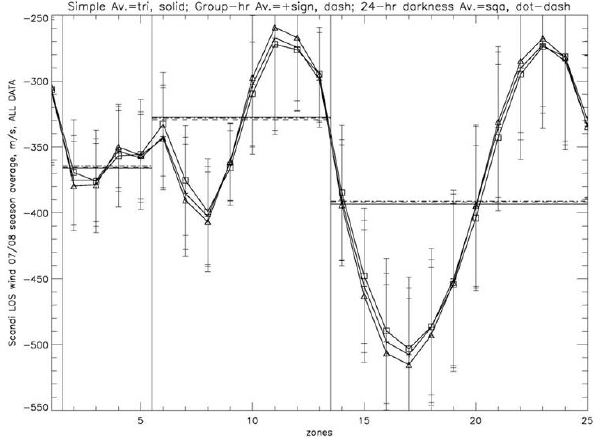
Fig. 9. Same as Fig. 7, but showing only SKY data. Here the data are averaged in 3 different ways (see text).